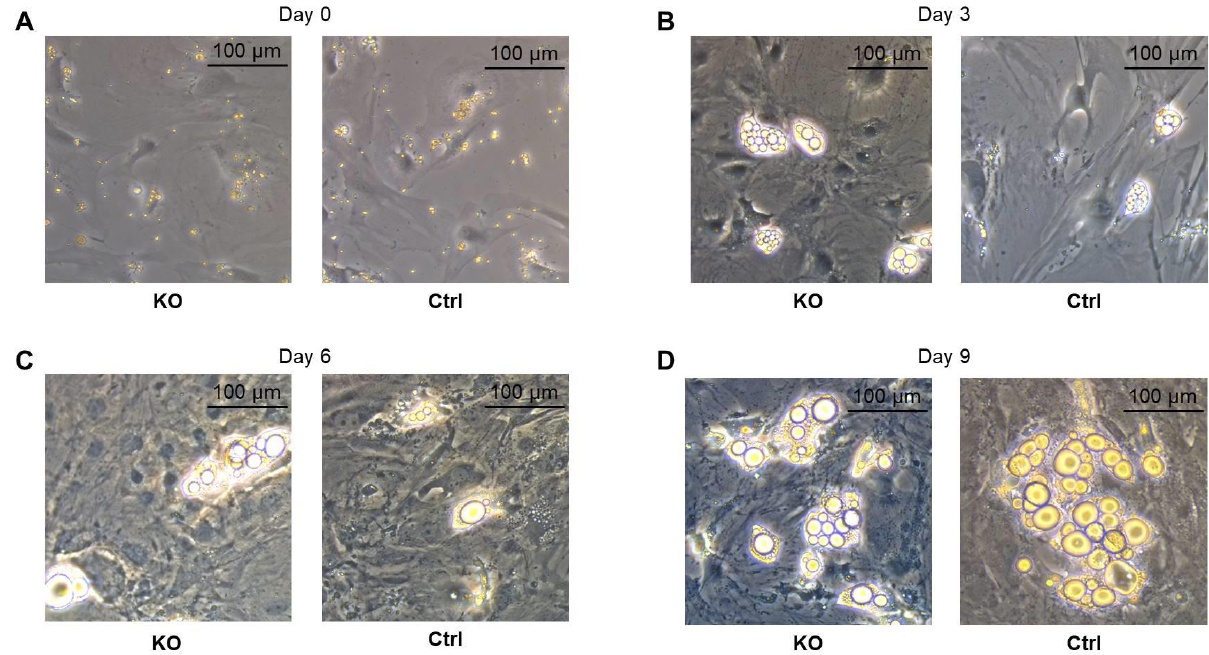
Figure 3. Differentiation of primary preadipocytes into mature adipocytes. Primary preadipocytes ( A ) were isolated from control littermates (Ctrl) and CTRP-3 KO animals (KO) and differentiated into mature adipocytes over 9 days by applying a hormonal differentiation protocol. Cellular phenotype is shown at days 3 ( B ), 6 ( C ), and 9 ( D ) of adipocyte differentiation (light microscopy, 200×). The process of differentiation and extensive lipid accumulation was apparently not altered by CTRP-3 KO.